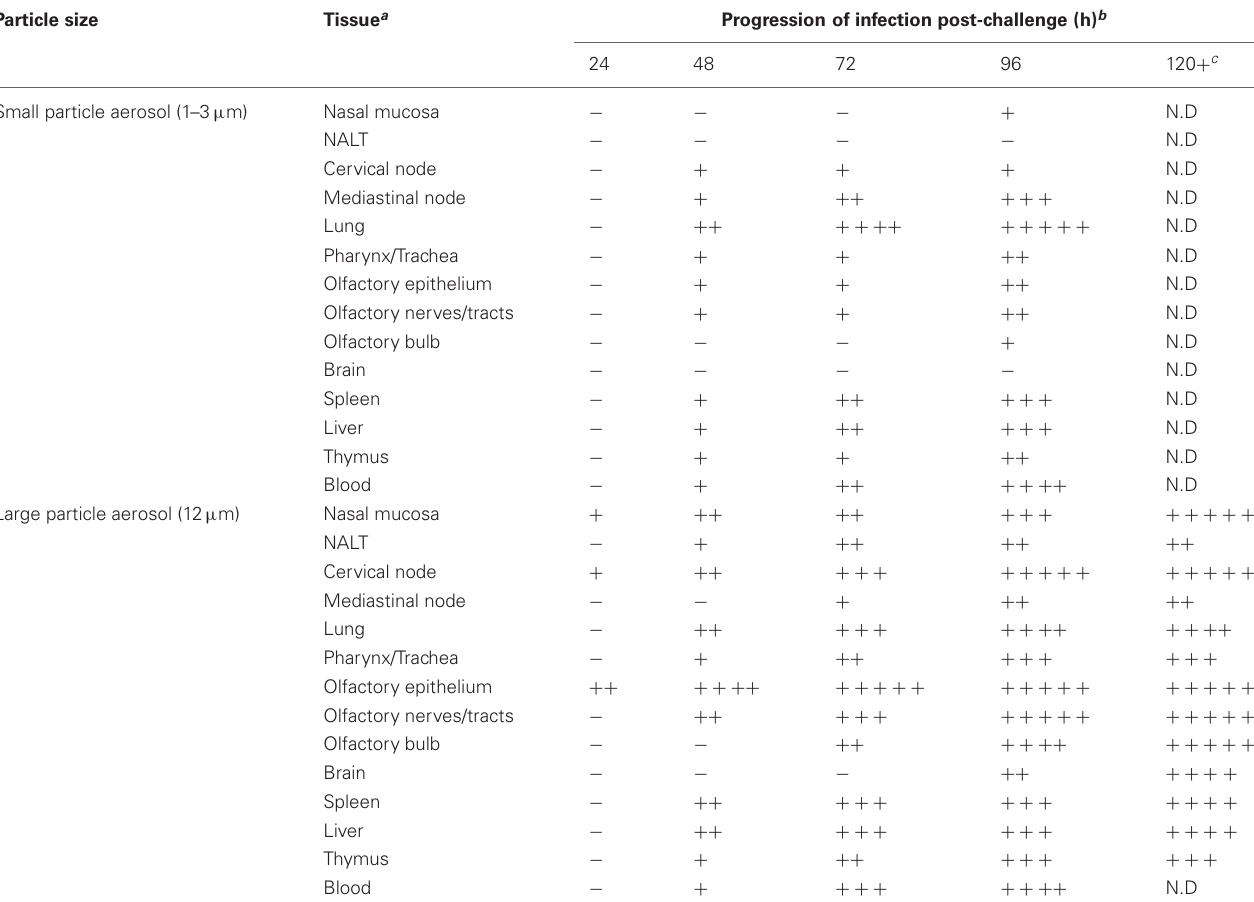
Table 1 | Comparative histopathological and bacteriological progression of inhalational melioidosis infections in the major tissues affected. Particle